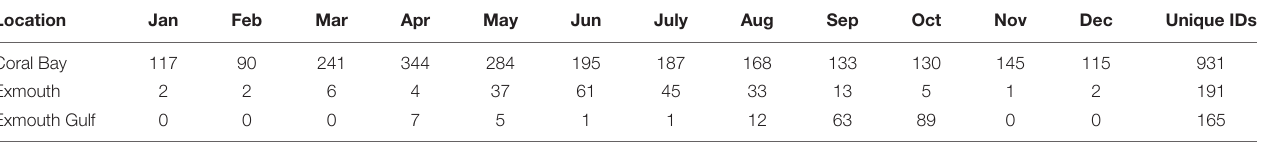
TABLE 3 | Total number of unique monthly sighting events for M. alfredi between 2005–2018 from Coral Bay, Exmouth (Ningaloo Reef) and the Exmouth Gulf. Location